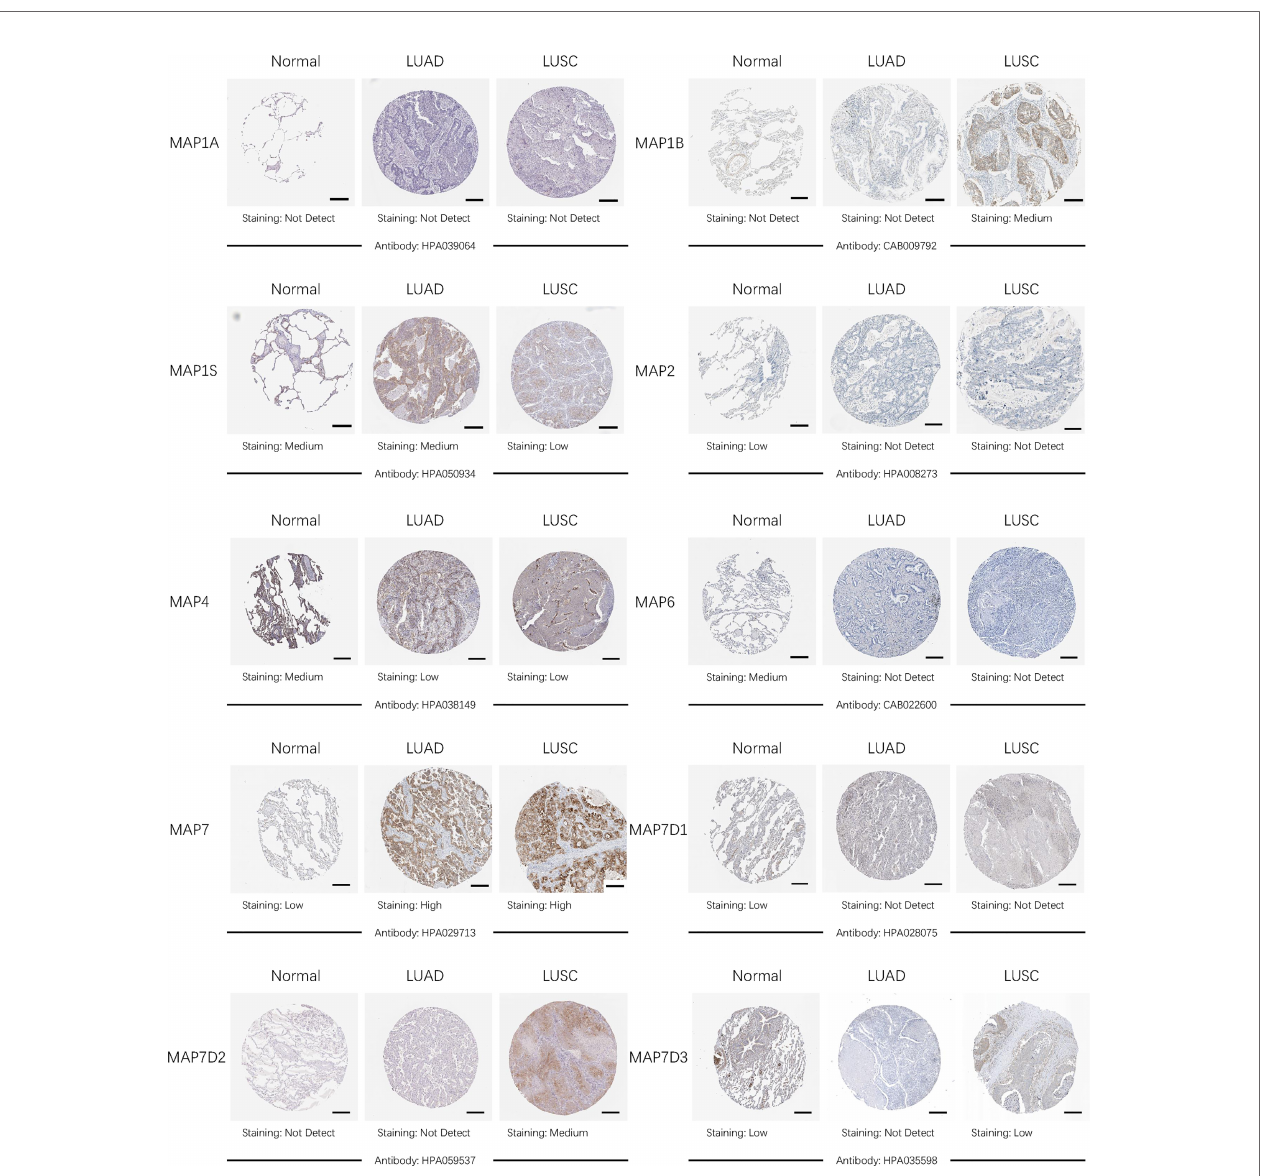
FIGURE 4 | Representative immunohistochemistry images of distinct MAPs in cancer and paratumor tissues (Human Protein Atlas). MAP, microtubule-associated